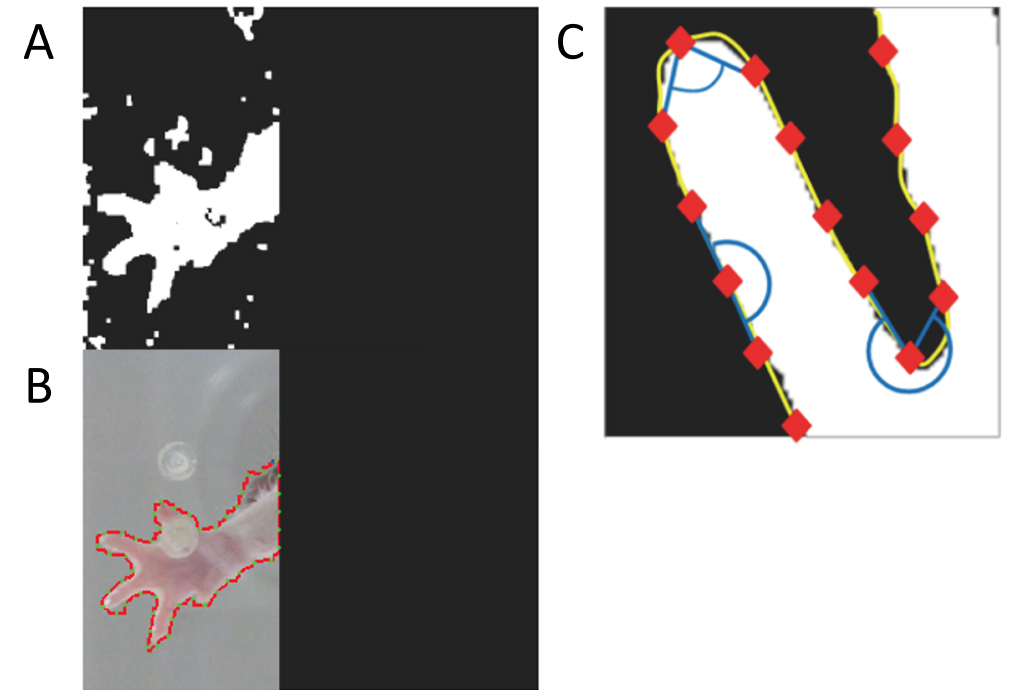
Fig. 3. Bottom-view image analysis. The bottom-view images obtained at the time of contact between the hand and the pellet are used to identify the tip of each finger. A binarized image of the hand (white area in A) is obtained against the background (black) using a background-differencing technique. After removing the noise and applying the labeling process, the hand outline is extracted (red line in B). Dots are placed on the contour lines (green dots on B and red diamonds in C), and the tip of each finger is considered as the point at which a sharp angle ( < 115 ◦ ) is made by three successive points (blue angles in